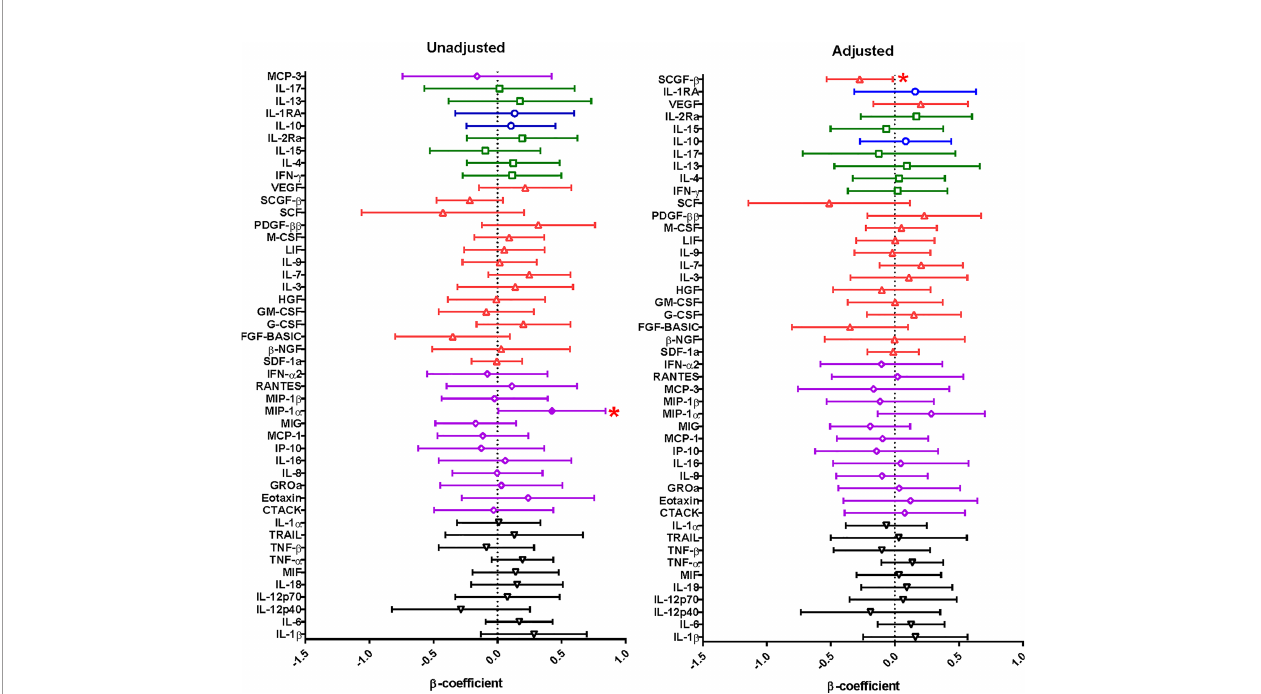
triangle, adaptive - green squares and anti-in fl ammatory cytokines – blue